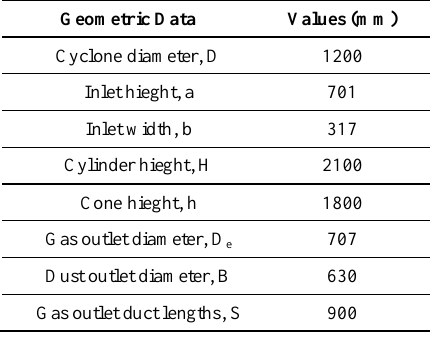
Table 4. Cyclone geometry used in this